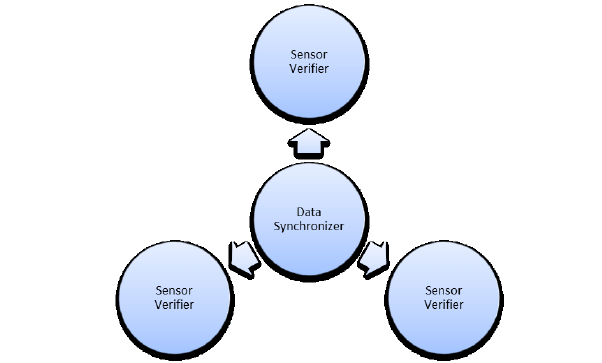
Figure 8. Aggregating Sensor Reading System process Model